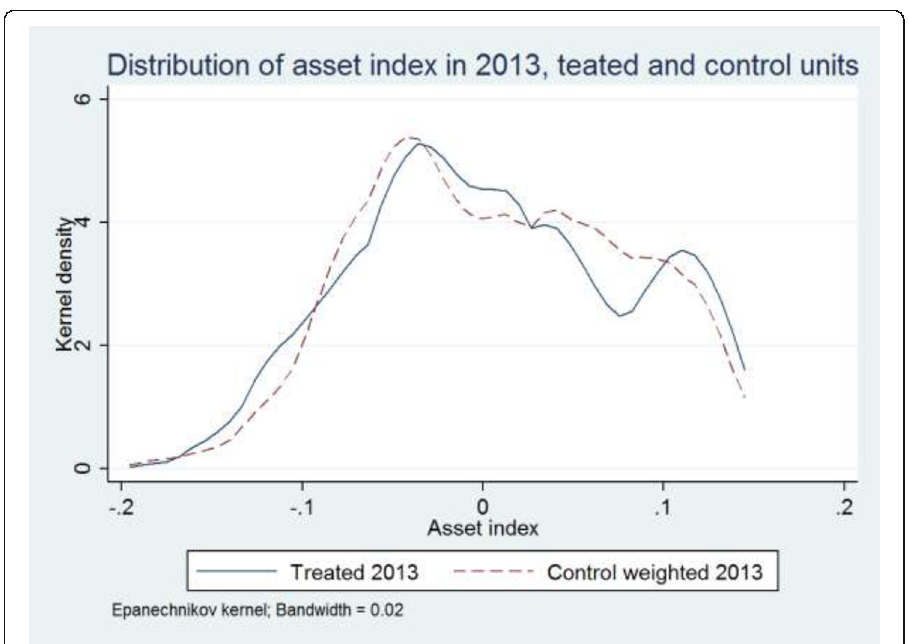
Fig. 2 Housing quality index of treated and control households in 2013